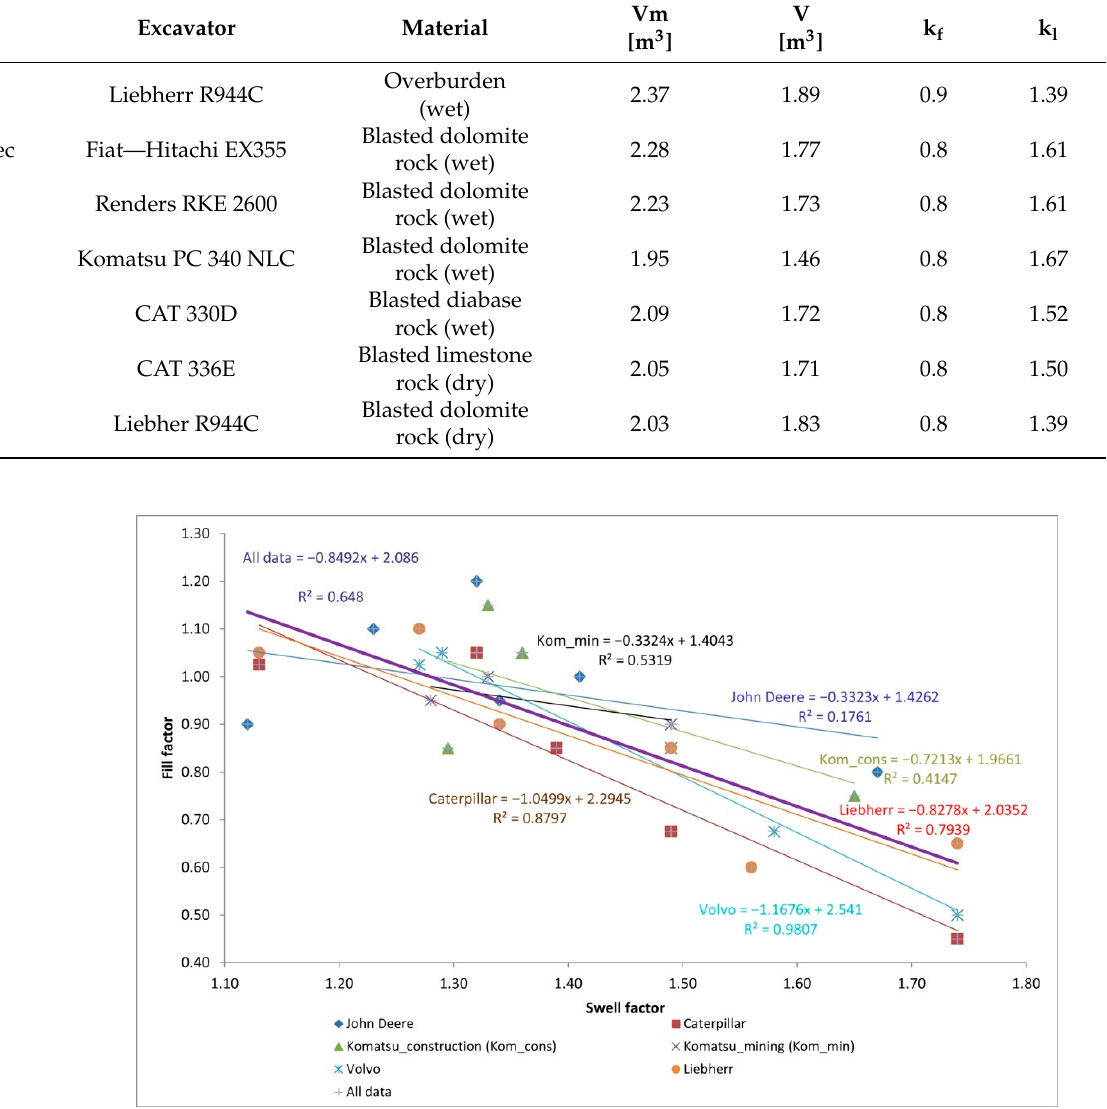
Figure 5. Dependence of the bucket fill factor on the swell factor of the material.